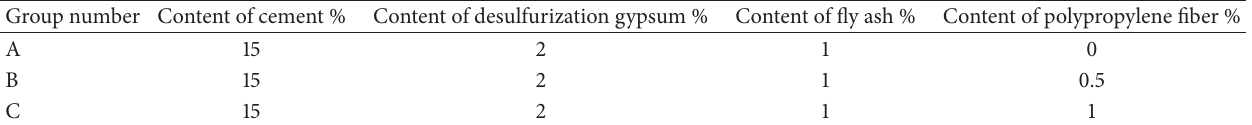
Table 5: The testing program.